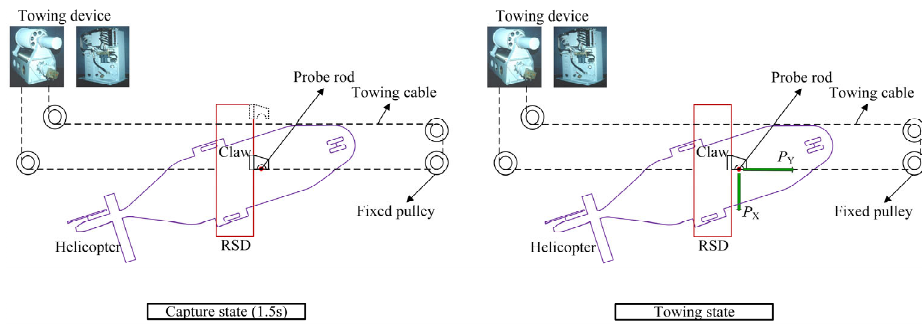
Figure 2. The working state of RSD and towing device.